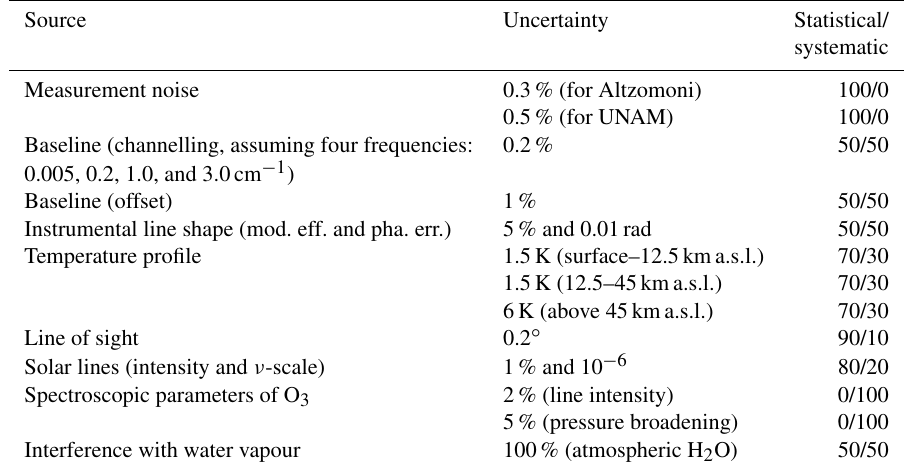
Table 1. Uncertainties used for the error estimation. The second column gives the uncertainty value and the third column the partitioning between statistical and systematic